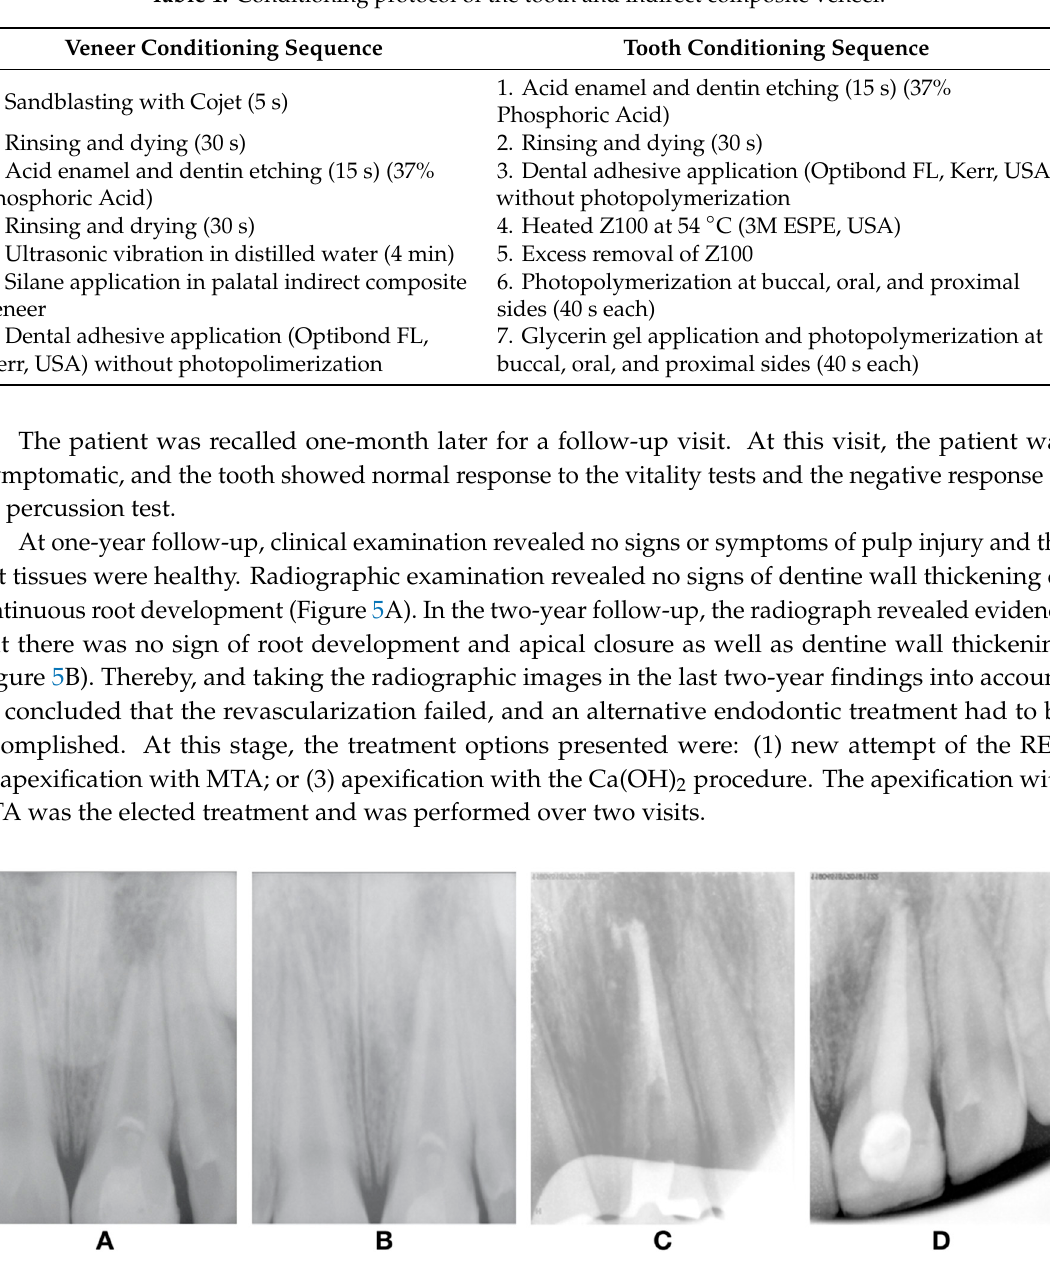
Figure 5. Follow-up radiographs after revascularization. ( A ) 1-year follow-up; ( B ) 4-year follow-up; and after ( C ) plug MTA; and ( D ) root canal obturation.